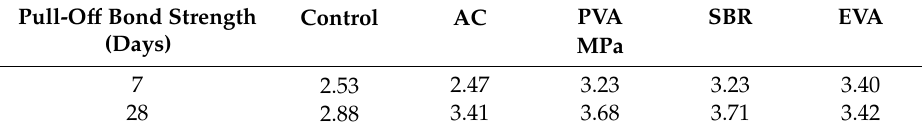
Table 7. Averaged pull-o ff bond strengths measured at seven and 28 days.